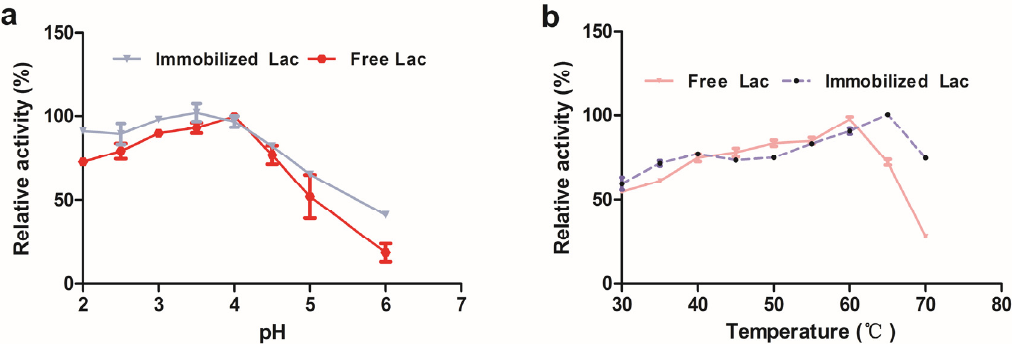
Figure 5. Effects of ( a ) pH and ( b ) temperature on Lac activity.